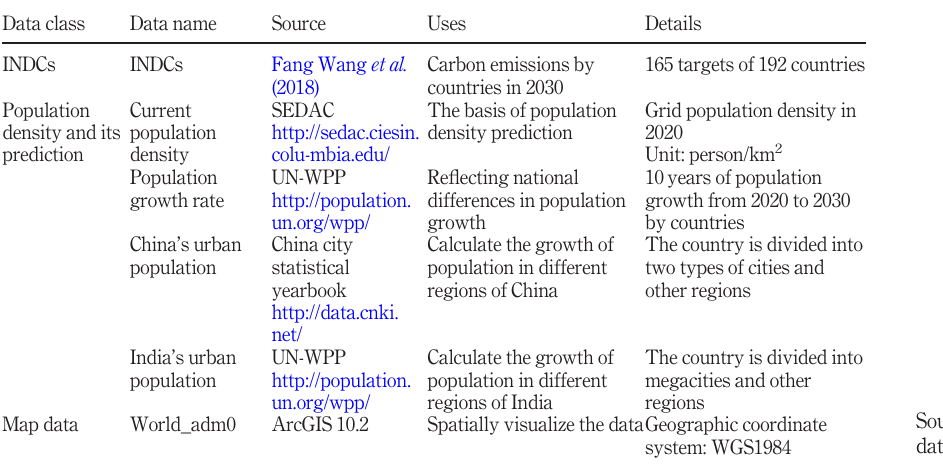
Table 1. Source and use